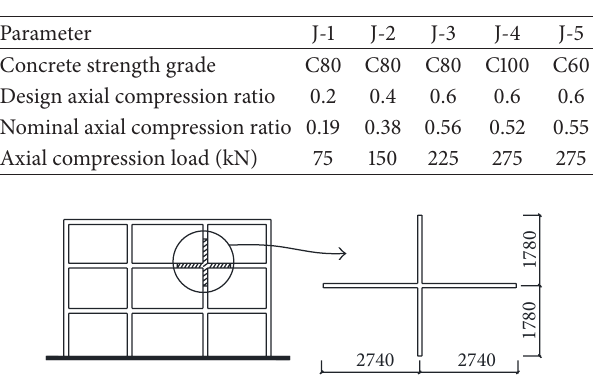
Table 1: Design parameter of beam-column assemblies.